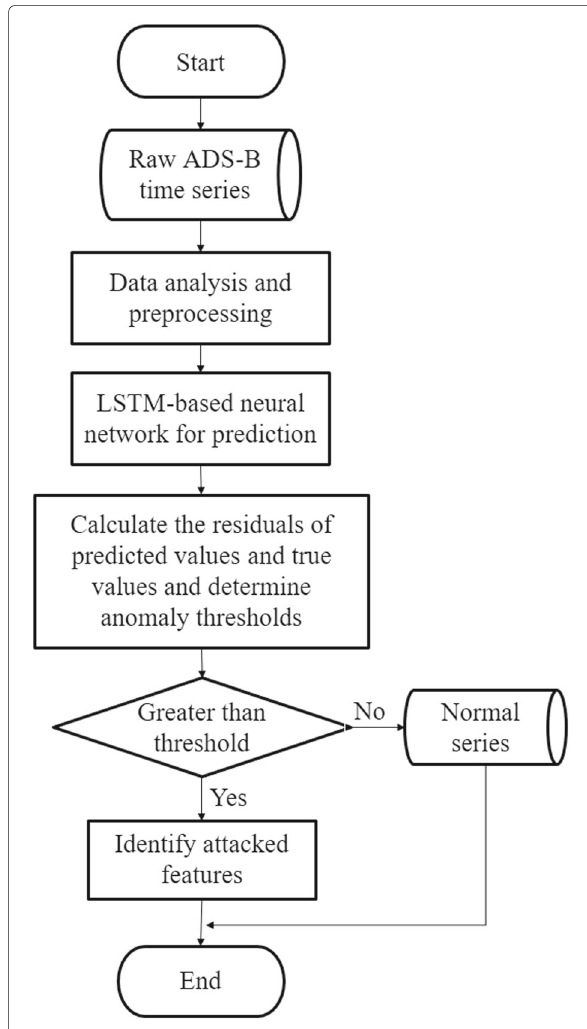
Fig. 2 Overall process of the method